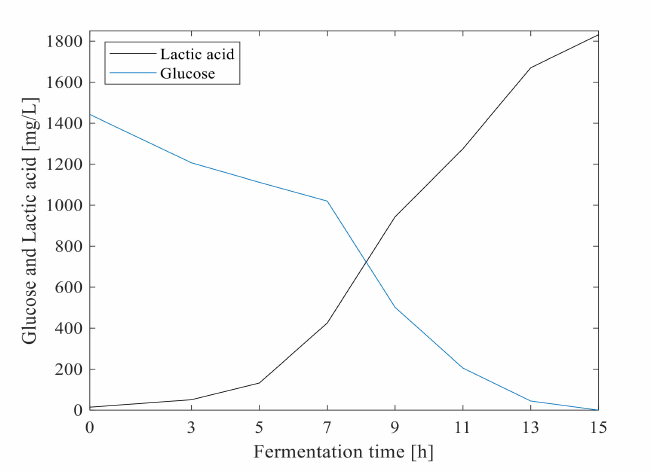
Figure 2. Glucose consumption and Lactic acid production during fermentation of 7 g/100 mL substrate inoculated with 6 log cfu/mL mixed strains of Lactiplantibacillus plantarum A6 and Lacticas- eibacillus rhamnosus